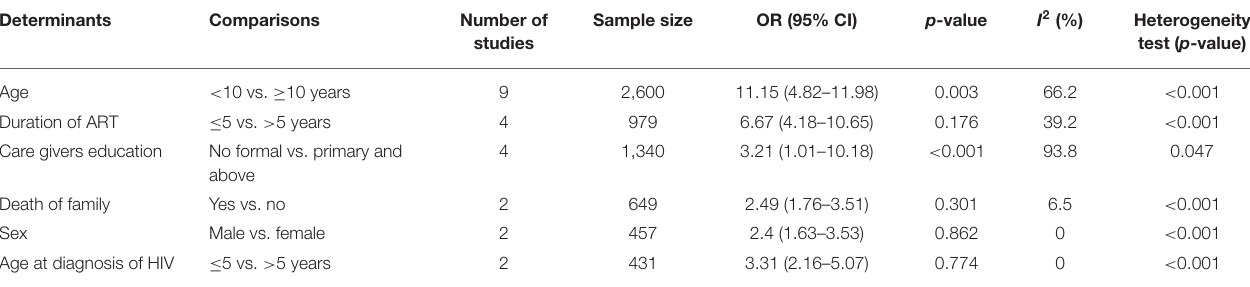
TABLE 2 | Factors associated with HIV serostatus disclosure among children in Ethiopia.